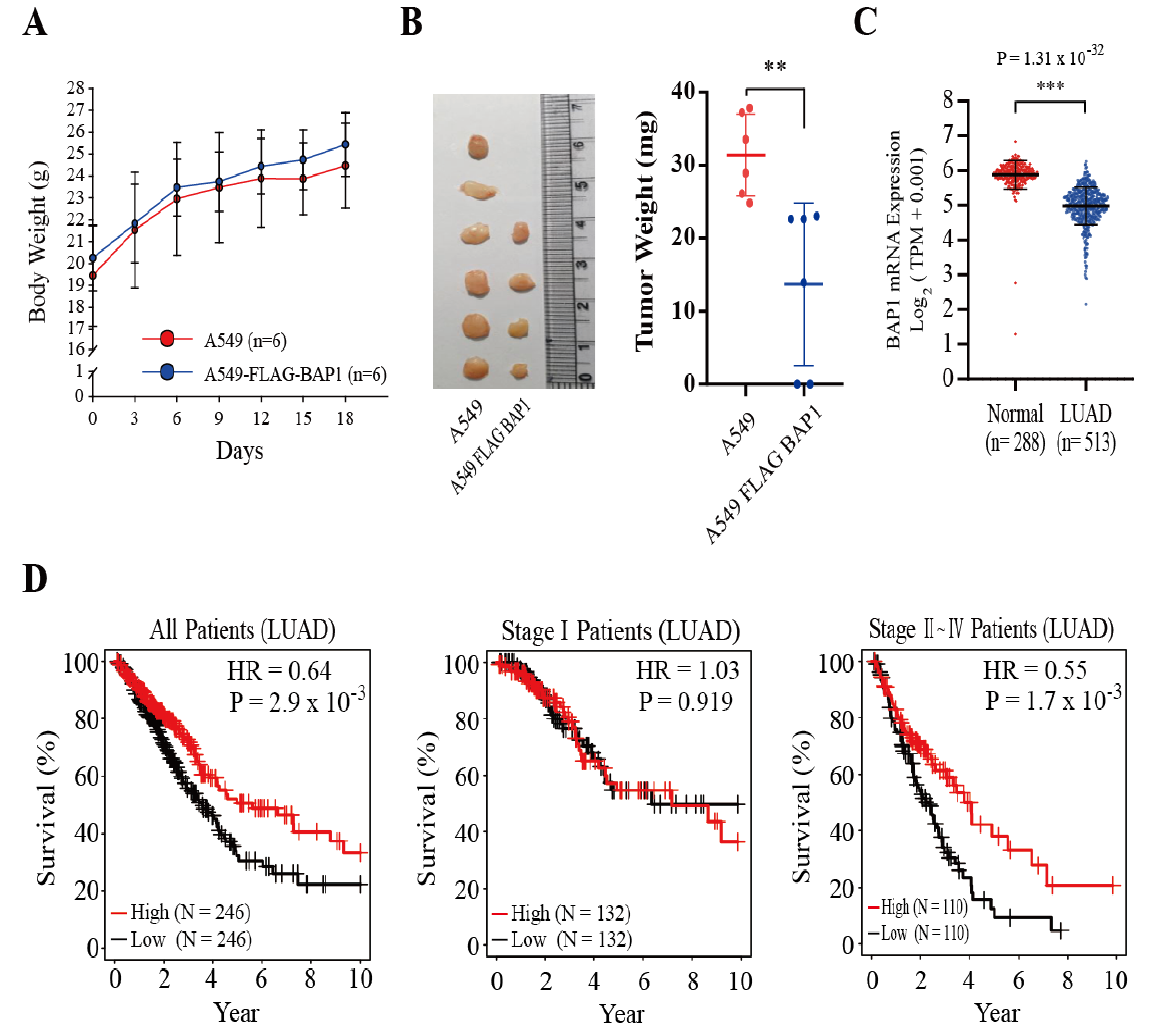
Figure 5. BAP1 suppresses the growth of A549 tumor xenografts and behaves as a tumor suppressor of LUAD. ( A ) The body weight of mice bearing A549 xenografts and A549-FLAG-BAP1 xenografts is indifferent. Athymic nude mice were injected with A549 cells ( n = 6) and A549-FLAG-BAP1 cells ( n = 6), and the body weights of mice were measured during the course of study. ( B ) Athymic mice bearing A549-FLAG-BAP1 xenografts produced fewer and smaller xenografts than mice bearing A549 xenografts. At sacrifice, the number (left panel) and the weight (right panel) of A549 and A549-FLAG-BAP1 xenografts were measured. ( C ) The expression of BAP1 mRNA levels is higher in normal lung samples than in LUAD samples. The mRNA levels (TPM) of BAP1 in normal and LUAD samples were obtained from the GTEx and the TCGA studies, respectively, in UCSC Xena (https://xena.ucsc.edu/, accessed on 25 March 2021). ( D ) The Kaplan–Meier curves show overall survival rate of LUAD patients at all stages (left panel), at stage I (middle panel), and at stages II–IV (right panel) stratified by BAP1-high and -low groups. ** p < 0.01, *** p < 0.001.